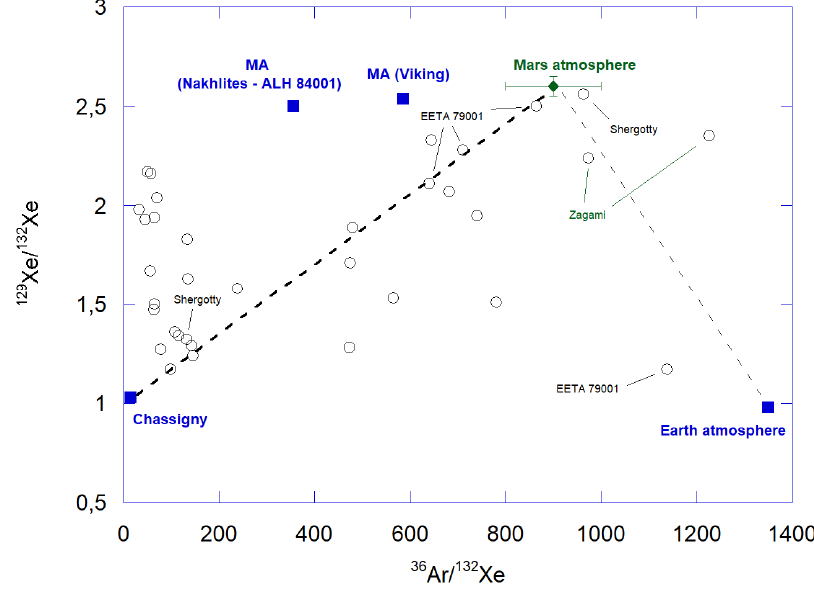
Figure 10. Plot of 129 Xe / 132 Xe vs. 36 Ar / 132 Xe in Martian meteorites, data compiled after Bogard and Garrison [94]. Martian atmosphere, based on meteorites (shergottites and nakhlites) and on the Viking data [20] (MA), Martian interior (Chassigny) as well as the Earth atmosphere are indicated. The “Mars Atmosphere” is estimated based on measurements on glass samples by Bogard and Garrison [98] and defined as 36 Ar / 132 Xe ~ 900 ± 100, 129 Xe / 132 Xe ~ 2.60 ± 0.05. Error bars are omitted on meteorite data for clarity. Adapted and modified from Bogard and Garrison [98].